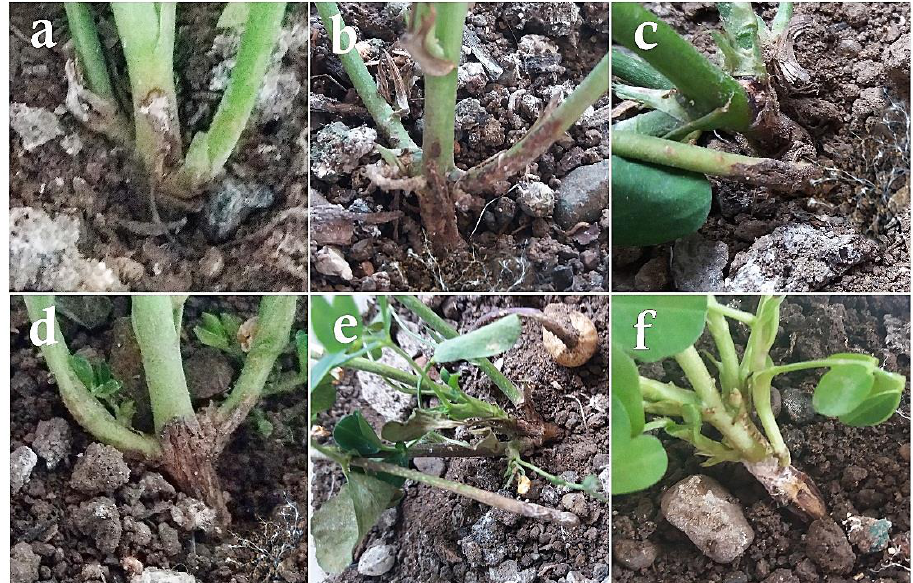
Figure 9. Greenhouse cultivation of A. hypogaea plants: ( a ) symptoms of the disease on the plants after inoculation with Sclerotium rolfsii and Trichoderma viride , ( b ) after inoculation with Sclerotium rolfsii and Aspergillus flavus , ( c ) after inoculation with Sclerotium rolfsii and Penicillium rubens (MN395854.1), ( d ) after inoculation with Sclerotium rolfsii and Penicillium rubens (MN395851.1), ( e ) after inoculation with Sclerotium rolfsii and Penicillium decaturense , ( f ) after inoculation with Sclerotium rolfsii and Trichoderma virens